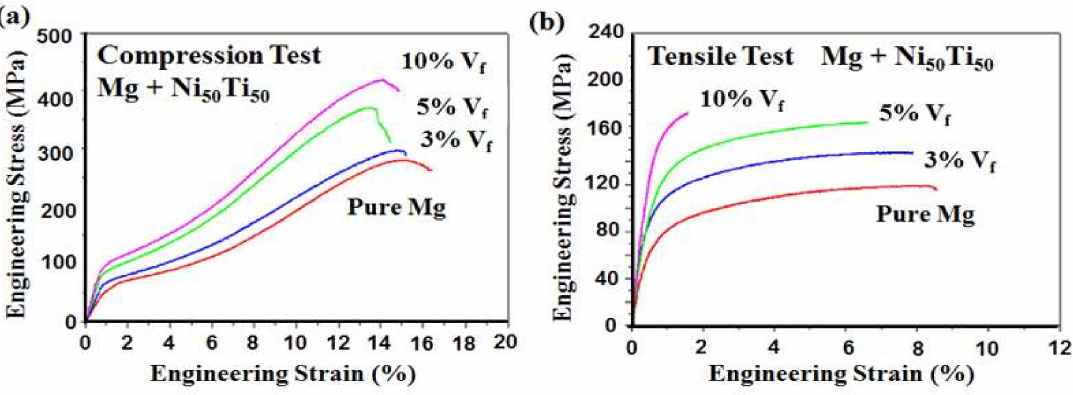
Figure 14. ( a ) Compression and ( b ) tensile properties of bi-directional microwave sintered pure magnesium reinforced with Ni 50 Ti 50 metallic glass [36]. (© 2015, Elsevier. Used with